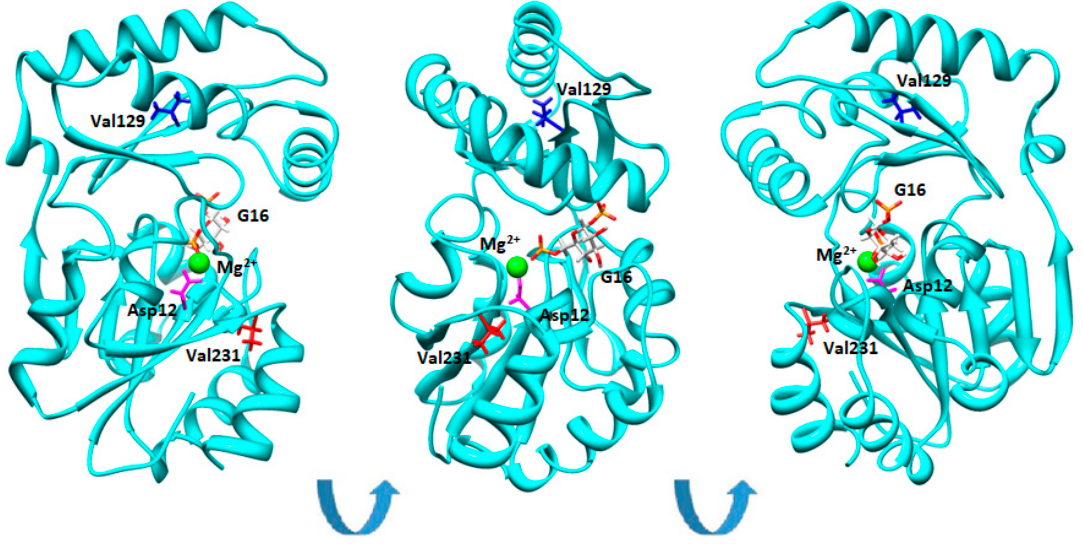
Figure 1. Val129 and Val231 in the structure of phosphomannomutase2. Phosphomannomutase 2 (PMM2) (single chain) is represented as cartoons. Asp12, Val129, and Val231 are shown as sticks in magenta, blue, or red, respectively. Glucose-1,6-bisphosphate (G16) is represented by sticks and is colored by atom types. Mg 2+ is represented by a green sphere. Different orientations of the same molecule are shown.